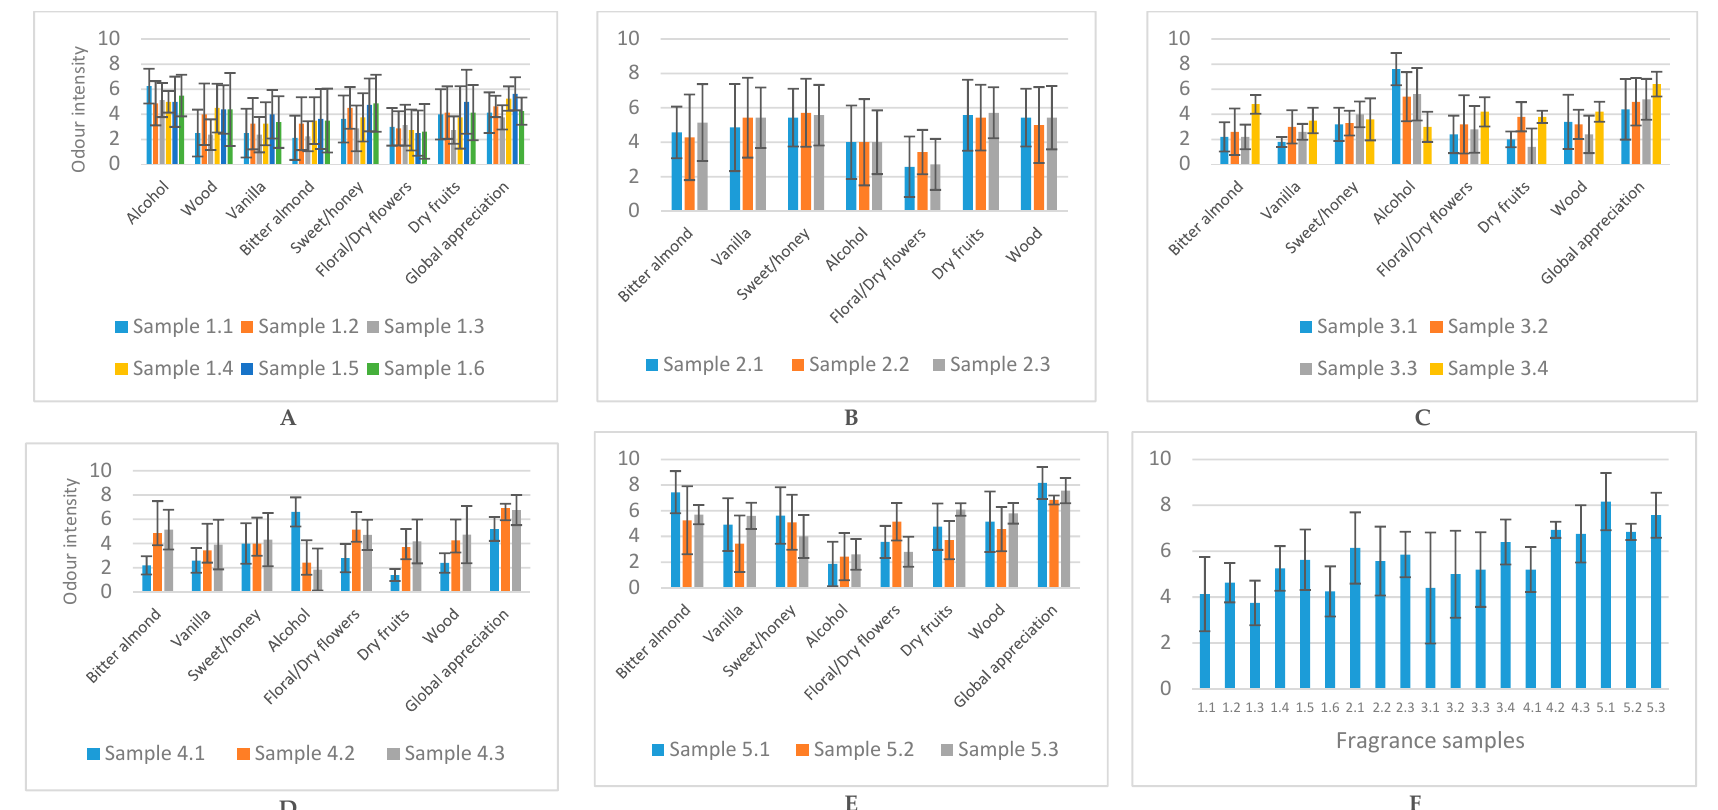
Figure 5. A —Mean intensity of descriptors obtained after the first sensory test with the first six fragrances developed; B —Mean intensity of descriptors obtained after the second sensory test with the three fragrances developed; C —Mean intensity of descriptors obtained after the third sensory test with the four fragrances developed; D —Mean intensity of descriptors obtained after the fourth sensory test with the three fragrances developed; E —Mean intensity of descriptors obtained after the fifth sensory test with the three fragrances developed; F —Global appreciation of all tawny port wine-like fragrances developed.